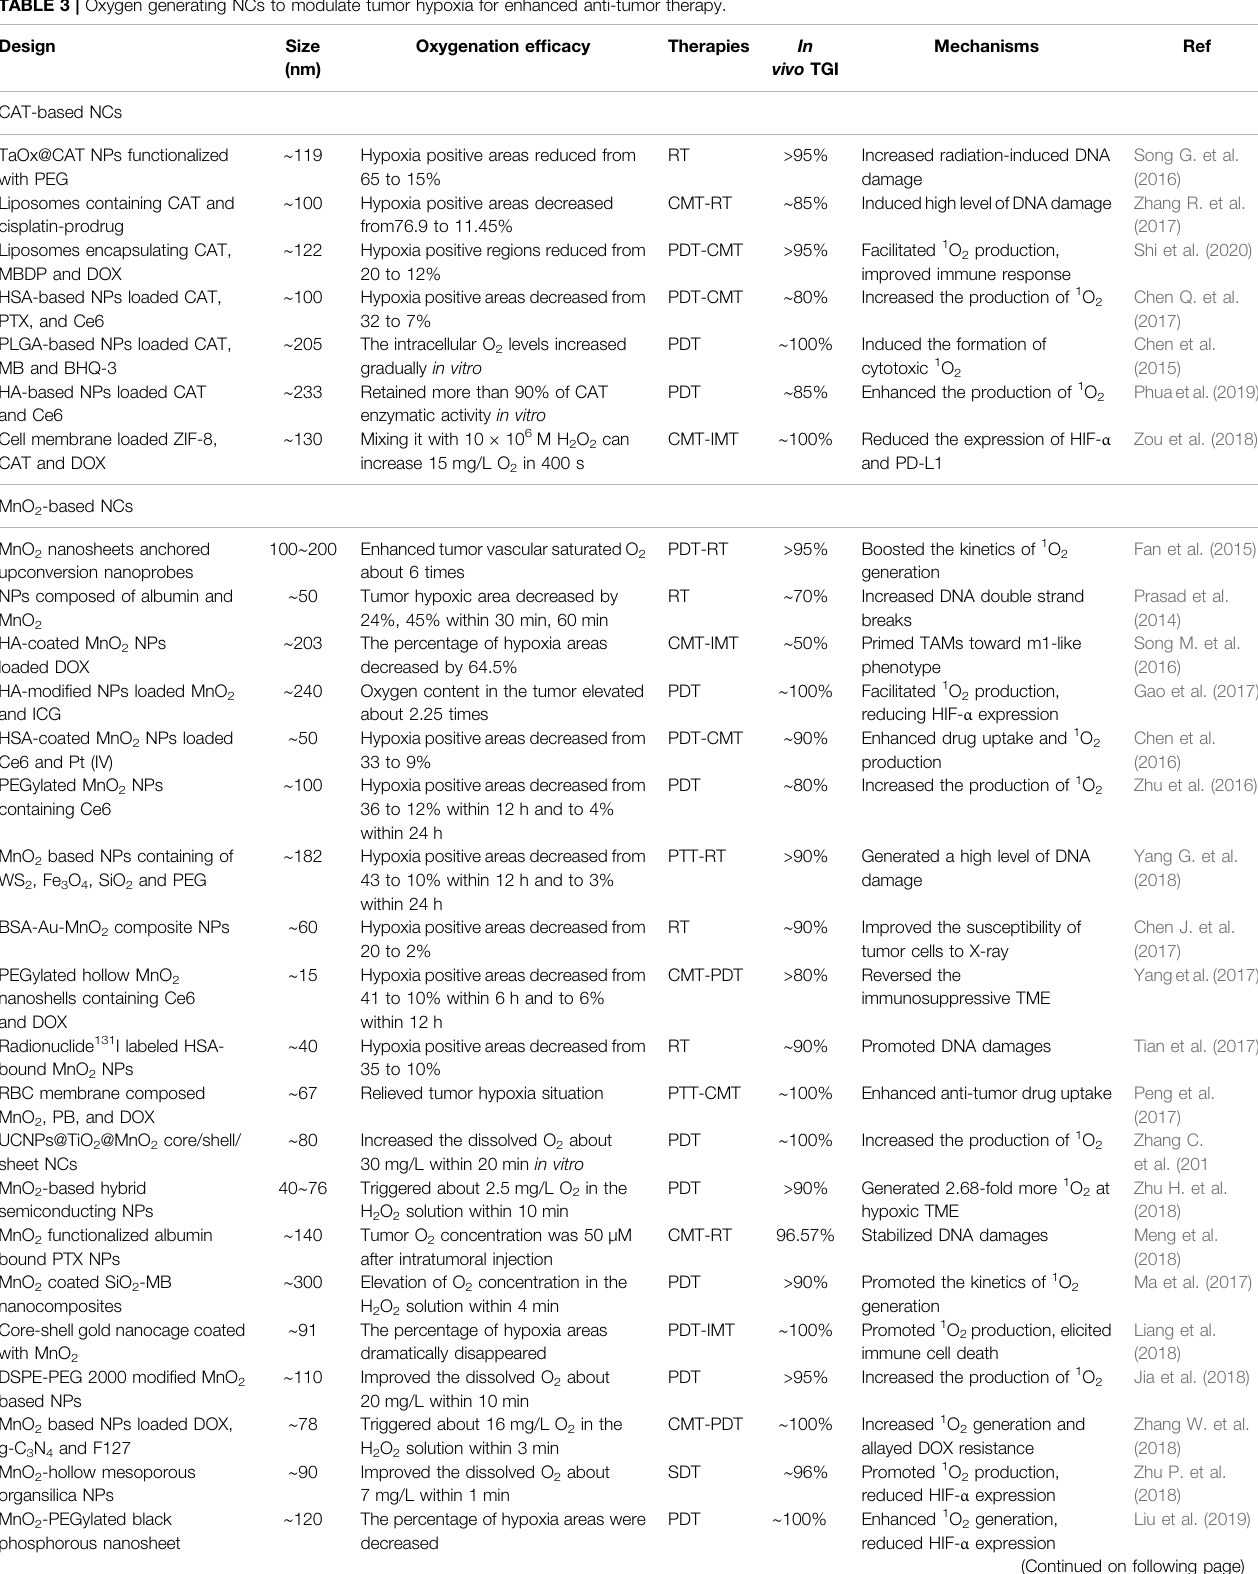
TABLE 3 | Oxygen generating NCs to modulate tumor hypoxia for enhanced anti-tumor therapy.